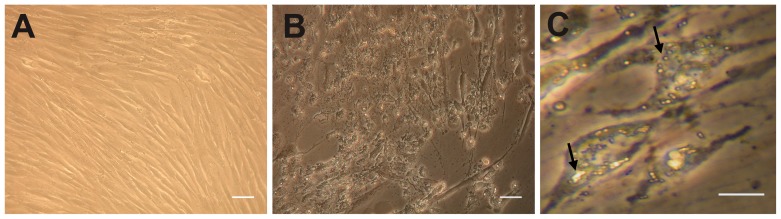
Morphology of DMSCs and ATII-LCs.Phase contrast images visualizing morphological changes of DMSCs during differentiation into ATII-LCs. A) Undifferentiated DMSCs showing a smooth and fibroblast-like morphology. B) Differentiated ATII-LCs after 4 days of incubation in differentiation medium, exhibiting a more flattened shape and a highly granulated cytoplasm. C) Magnified view of ATII-LCs displaying groups of highly-refractive cytoplasmic particles (arrows). Scale bars in A and B correspond to 100 µm and in C to 50 µm.